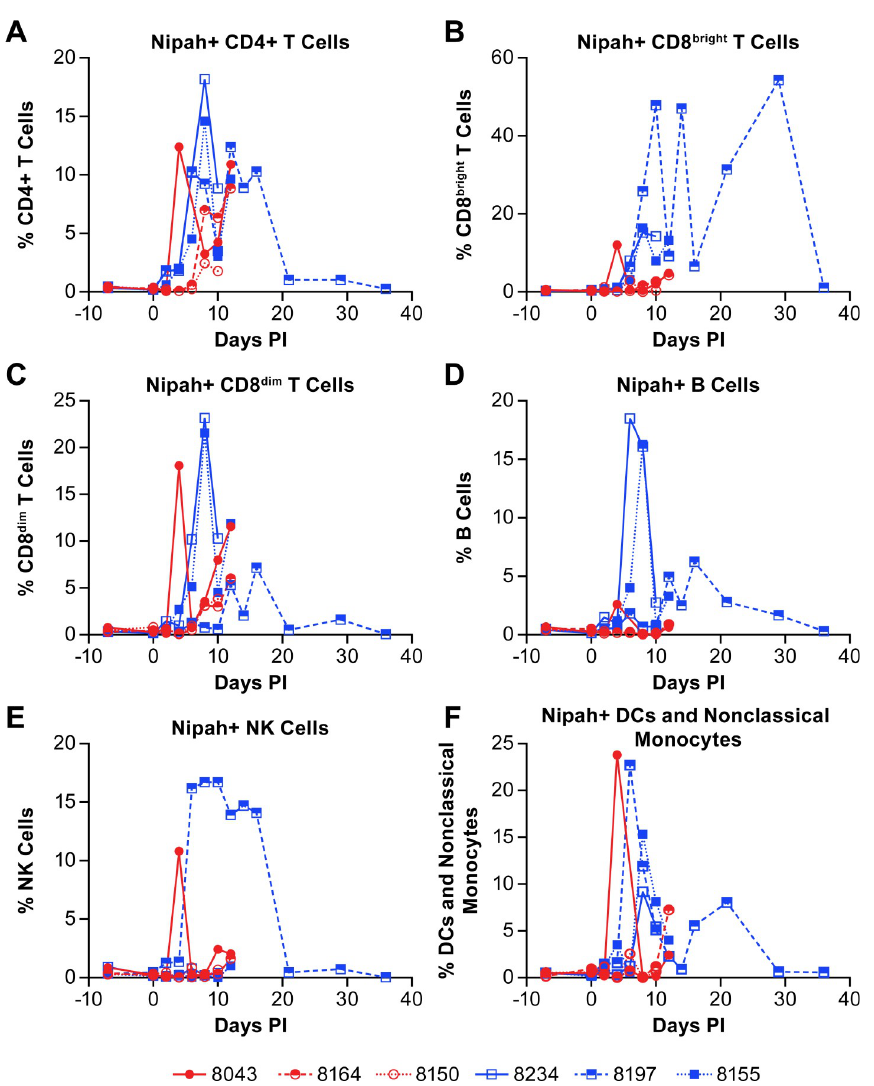
Fig 11. Determination of cell populations containing NiV antigen. The presence of NiV was determined in individual cell populations by flow cytometry. Antigen was identified in CD4+ T cells (A), CD8 bright T cells (B), CD8 dim T cells (C), B cells (D), NK cells (E) and a combined population of DCs and non-classical monocytes (F). Red circles indicate the low dose group and blue squares indicate the high dose group. The cell surface markers for defining individual populations is provided in S3